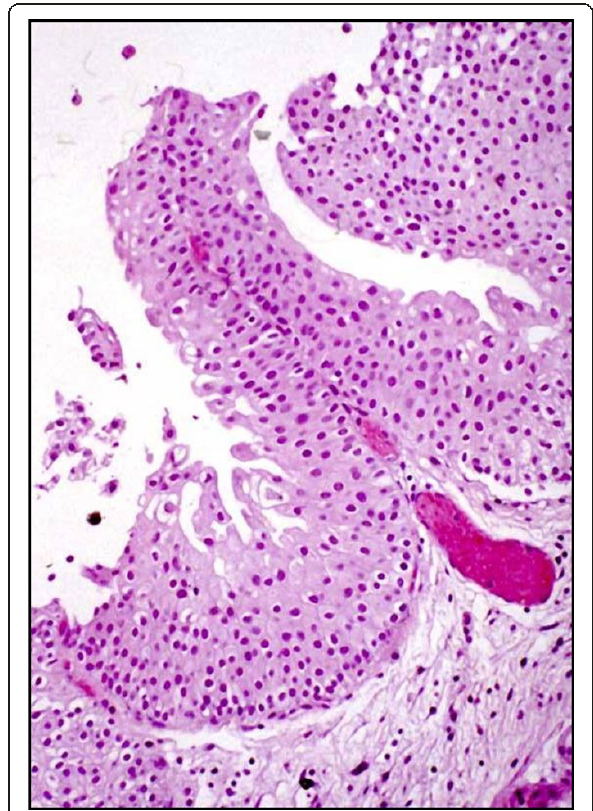
Figure 4 Papillary urothelial hyperplasia (pseudopapillary hyperplasia) . Figure 5 Urothelial dysplasia